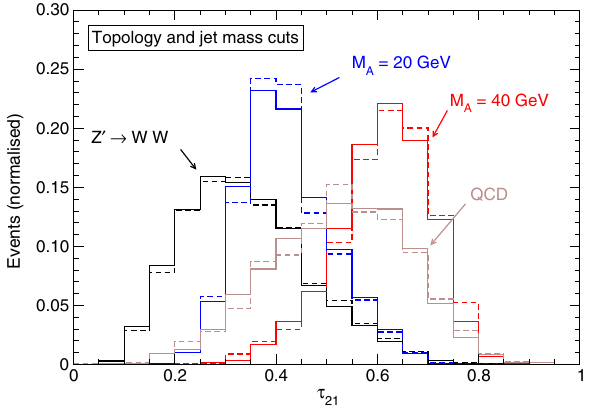
Fig. 3 N -subjettiness ratio τ 21 for R → SS and Z (cid:8) → WW signals and the QCD dijet background. Solid (dashed) lines correspond to the leading (subleading)